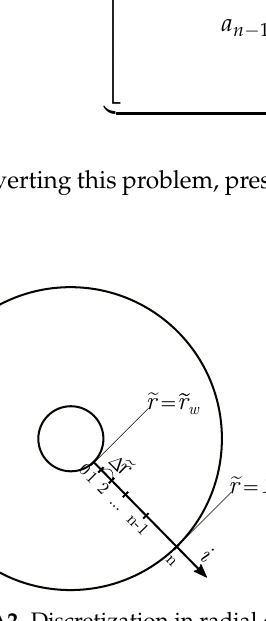
Figure A2. Discretization in radial direction.